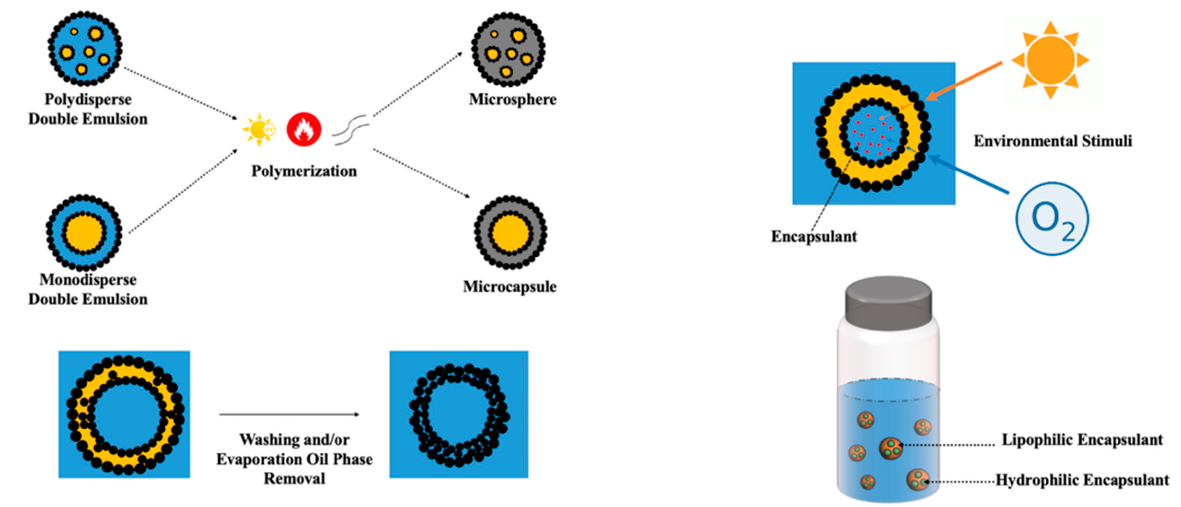
Figure 9. Applications of PDE.